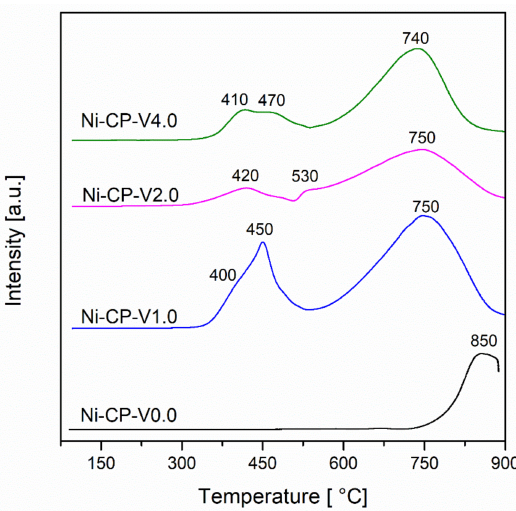
Figure 3. H 2 -TPR profiles for calcined